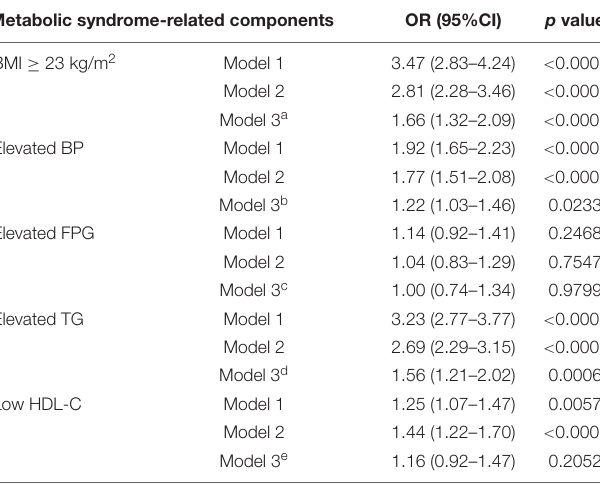
TABLE 3 | Correlations between serum UA levels and anthropometric and laboratory parameters in all individuals. Variable